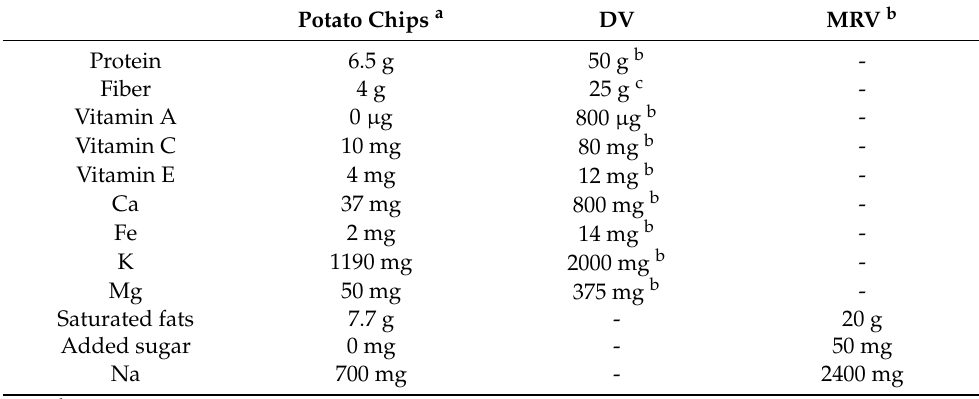
Table 2. Nutrient content of potato chips, DVs, and MRVs for a 2000 kcal daily